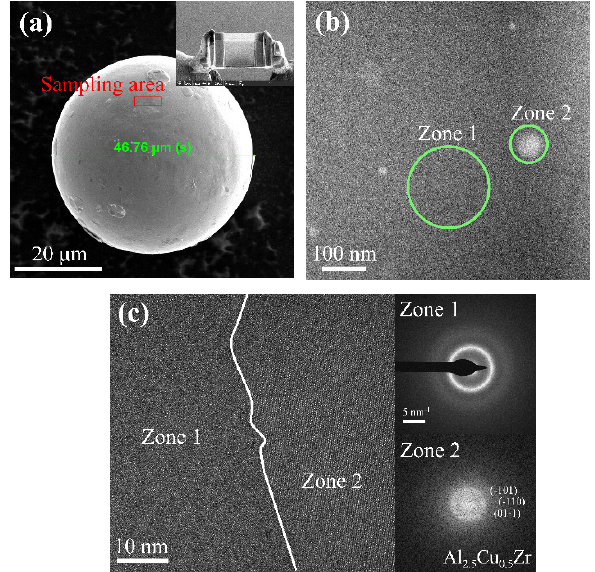
Figure 4. TEM analyses of (Cu 43 Zr 47 Al 7 Ag 3 ) 99.5 Co 0.5 amorphous powder. ( a ) A typical powder with the diameter of 46.76 μm, ( b ) the TEM bright-field image, ( c ) the HRTEM image obtained at the interface of Zone 1 and Zone 2. The insert images: the diffraction pattern of Zone 1 and the FTT of Zone 2.